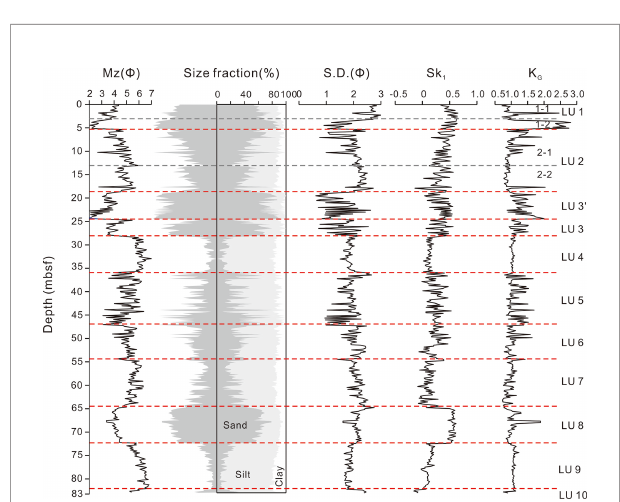
FIGURE 4 | The grain size composition of borehole SFK-1. Mz, mean grain size (phi); S.D., standard deviation; Sk I , skewness; K G ,